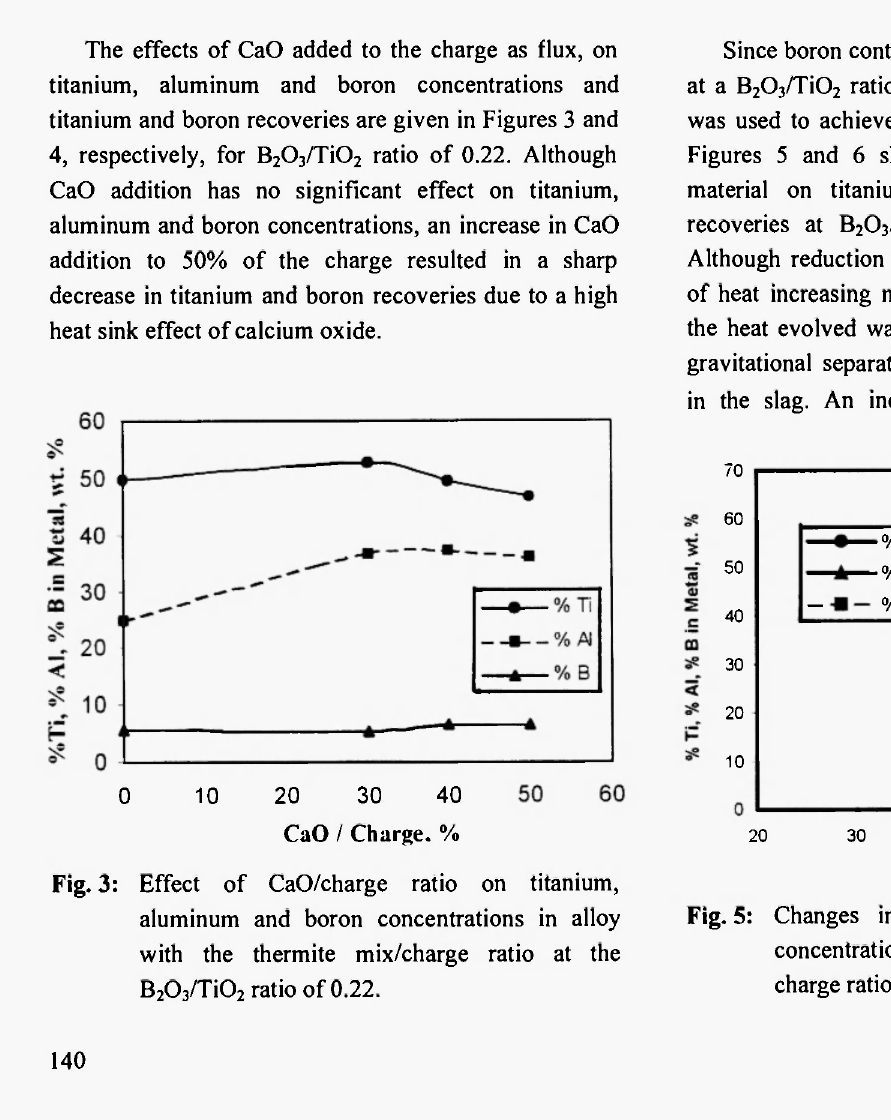
Fig. 2: Variation of titanium and boron recovery in alloy with the thermite mix/charge ratio at the B 2 0 3 /Ti0 2 ratio of 0.22.